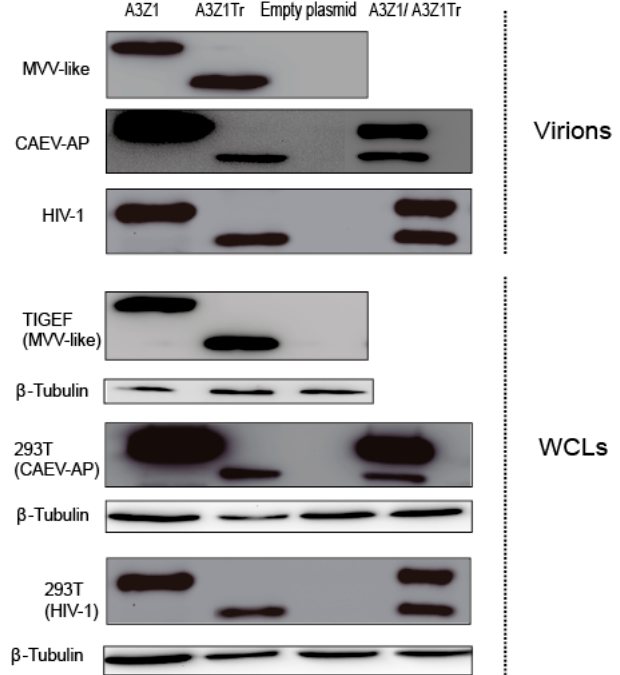
Figure 4. APOBEC3 encapsidation into SRLVs and HIV-1 virions. A3Z1, A3Z1Tr, empty plasmid and